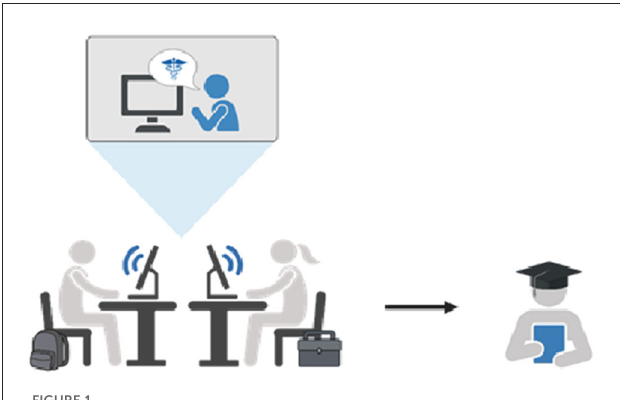
FIGURE1 Information flow in telehealth case